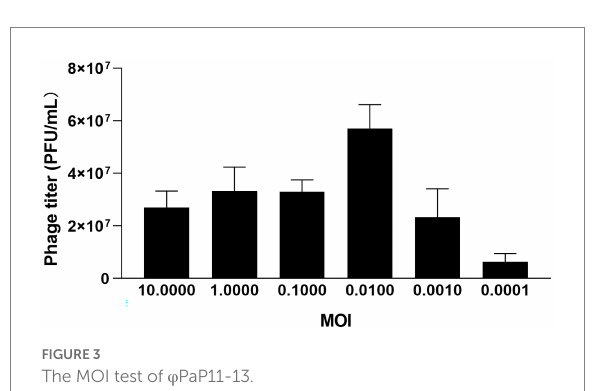
FIGURE 3 The MOI test of φ